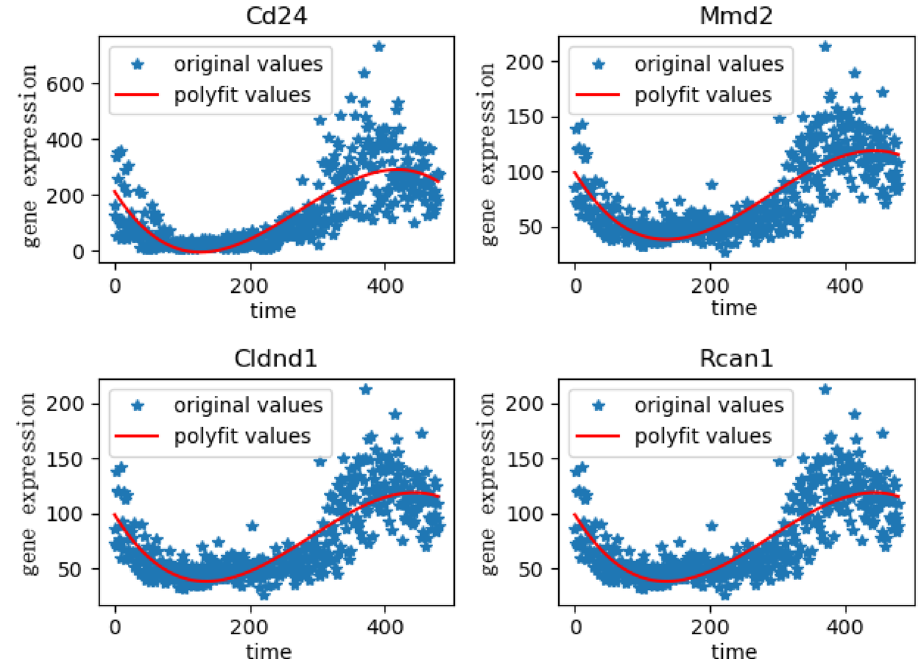
Figure 11. Some genes in the screening